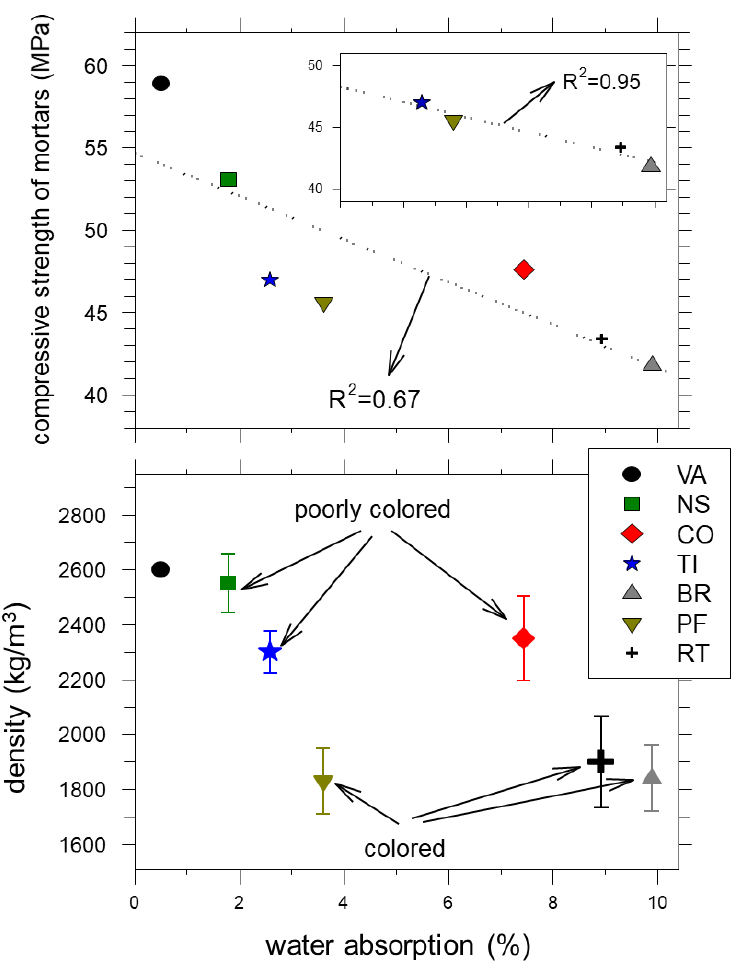
Figure 8. General reappraisal of mesoscopic appearance (colour), density and mass volume (bottom) and compressive strength as a function of water absorption of the six RAs .